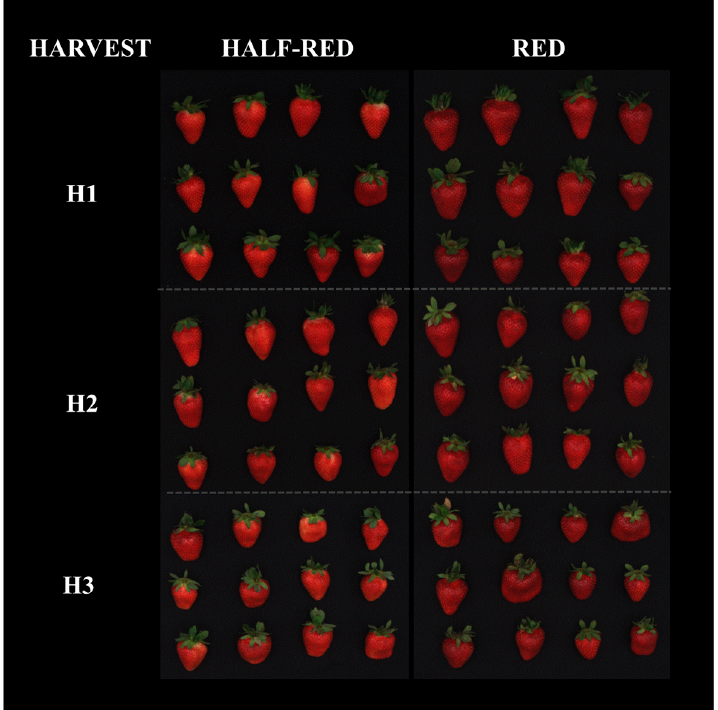
Figure 1. “Candonga” strawberries (var. Sabrosa) harvested at two different ripening stages, namely half ‐ red (in ripening phase, fully expanded and 50% red, indicated as Half ‐ red ‐ H1, Half ‐ red ‐ H2 and Half ‐ red ‐ H3) and red (in ripening phase, fully expanded and 100% red, indicated as Red ‐ H1, Red ‐ H2 and Red ‐ H3).